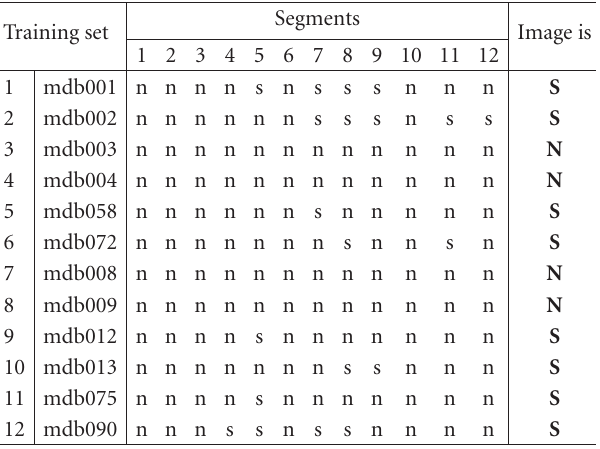
Table 1: Decision table for training set segments. Training